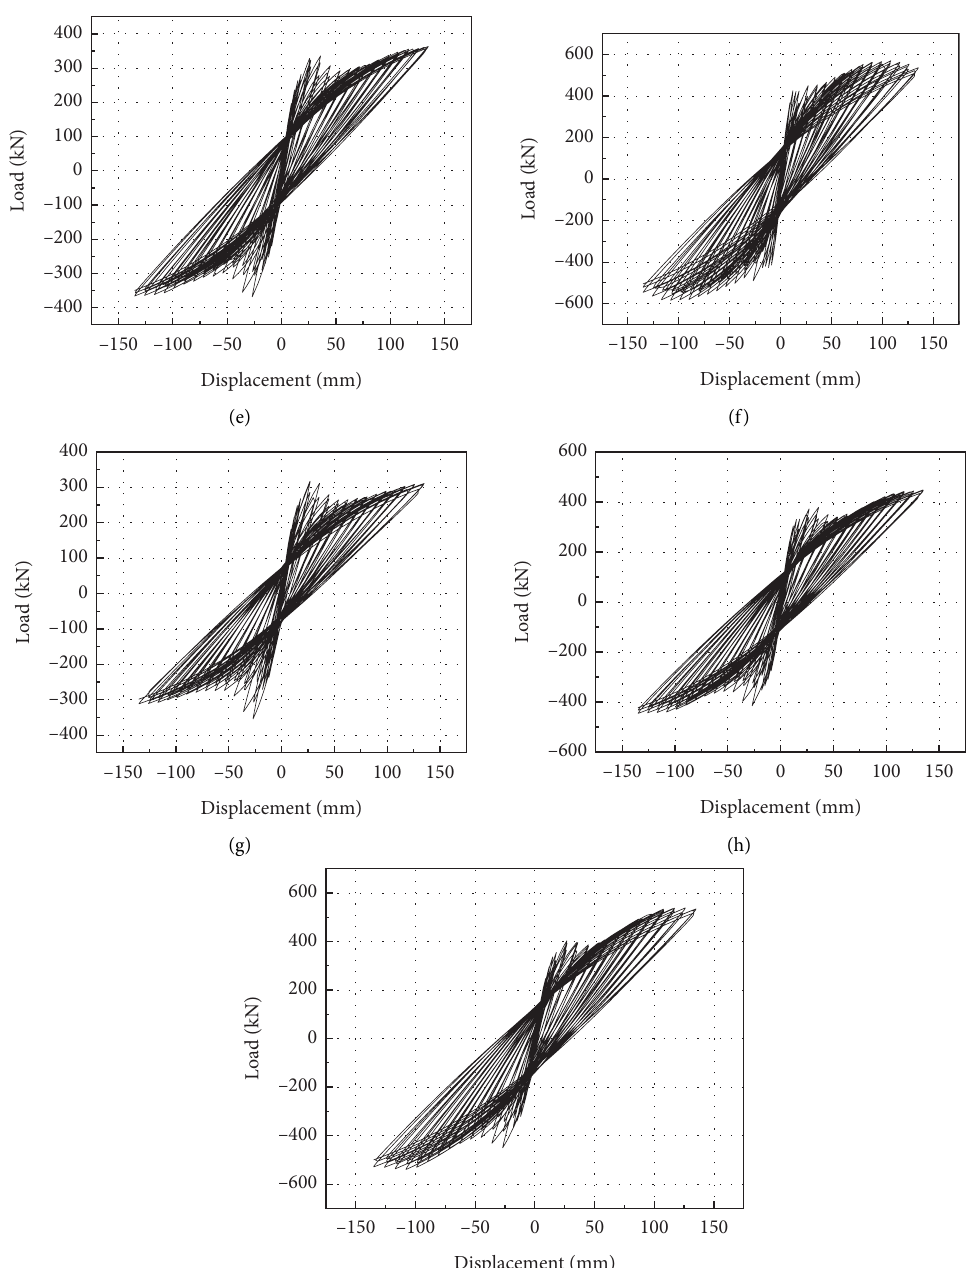
Figure 11: /e hysteretic curve of each specimen. (a) KJ-1, (b) KJ-T-1, (c) KJ-T-2, (d) KJ-T-3, (e) KJ-T-4, (f) KJ-T-5, (g) KJ-T-6, (h) KJ-T-7, and (i)